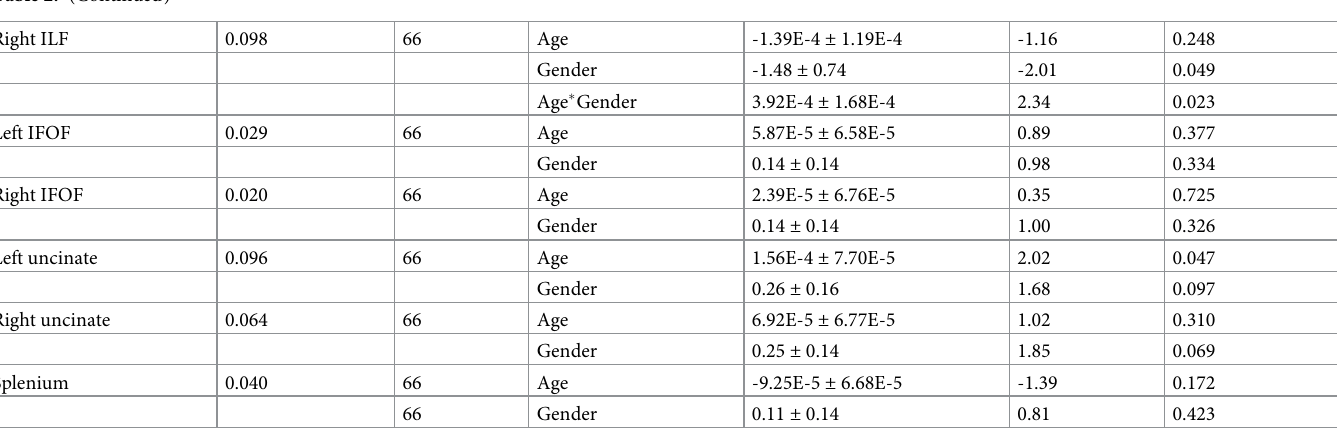
Significant effects that survive multiple comparisons are bolded and marked by an asterisk.